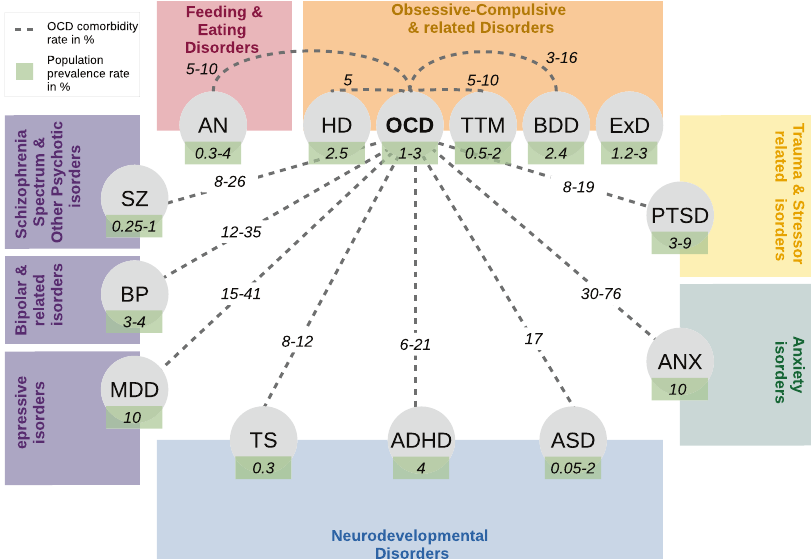
Fig. 3 Phenotypic associations between OCD and other psychiatric disorders, grouped by their DSM-5 categorization. Comorbidity estimates between OCD and AN [95, 96], TS [88, 89], HD [128], TTM [91, 100], BDD [91, 100, 129], ExC [62, 109], PTSD [1, 100], ANX [1, 91], MDD [1, 91, 92], ASD [97], ADHD [1, 91, 99, 100], BP [100, 130], and SZ [130] are on the dashed lines, while the green boxes indicate the population prevalence of each disorder (OCD [2]; AN [131]; TS [132]; HD [82]; TTM [85, 86]; BDD [83, 84]; ExD [87, 105, 133]; PTSD [90, 134, 135]; ANX [1, 90]; MDD [1, 90]; ASD [97, 98]; ADHD [90]; BP [136, 137]; and SZ [138,